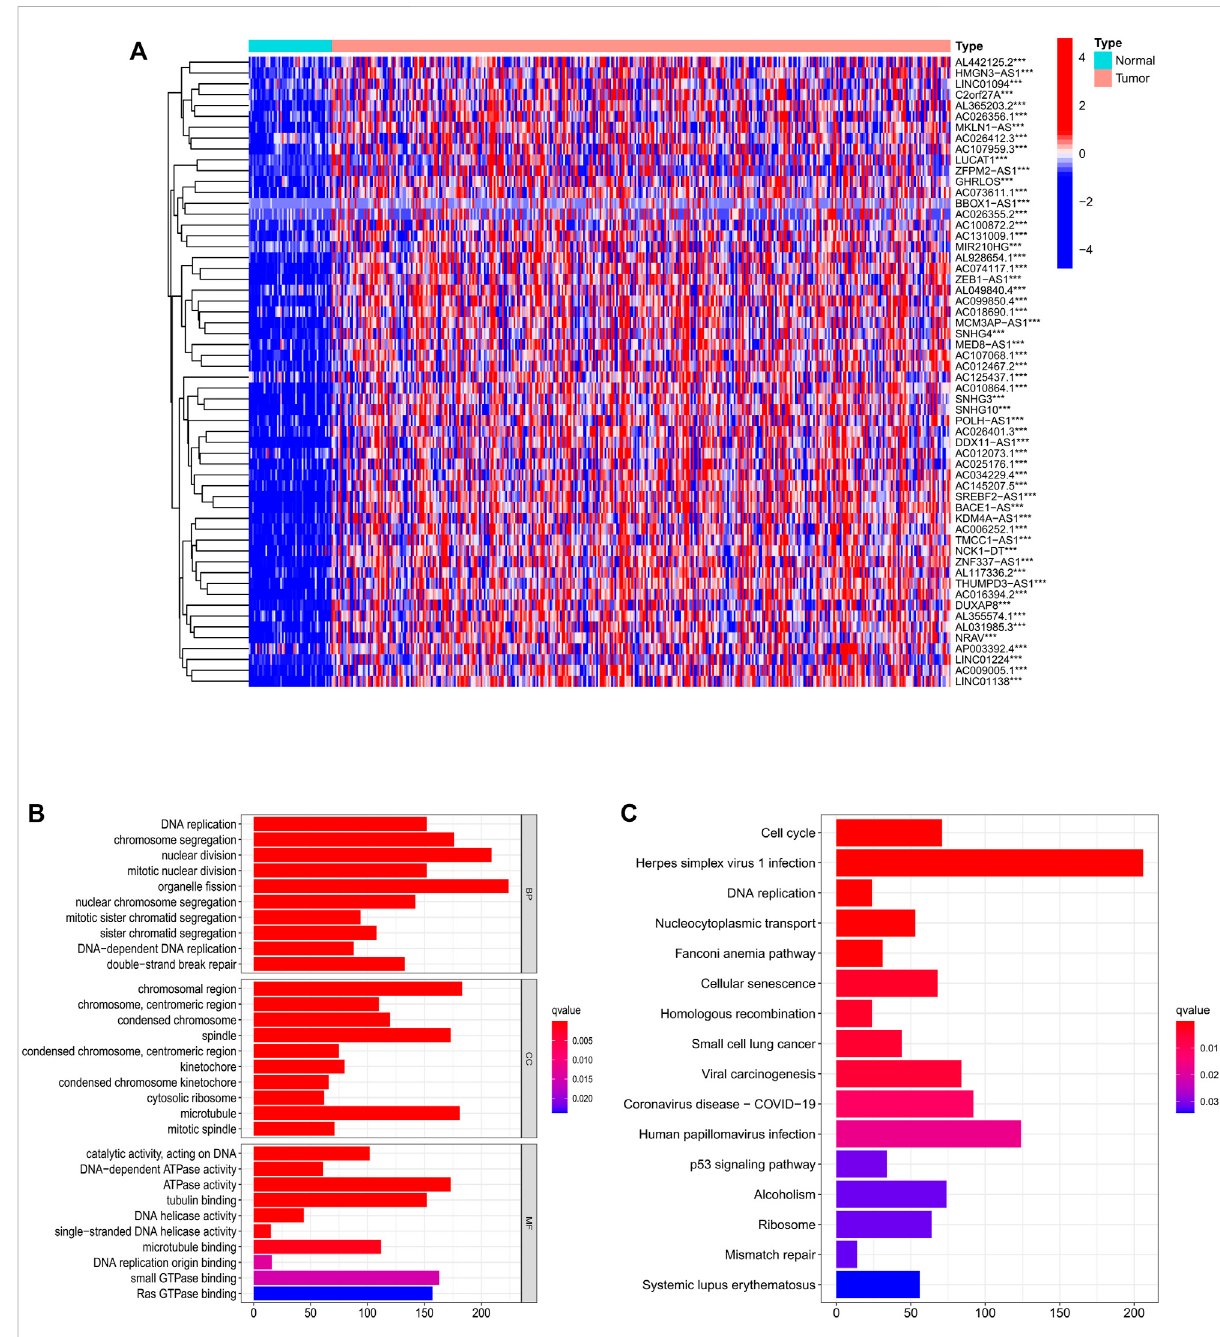
FIGURE 3 Identi fi cation of PRlncRNAs. (A) Differential expression of PRlncRNAs in tumor and adjacent normal pairs. (B – C) GO and KEGG enrichment analysis results. PRlncRNAs: prognostic-related lncRNA; GO: Gene Ontology; KEGG: Kyoto Encyclopedia of Genes and